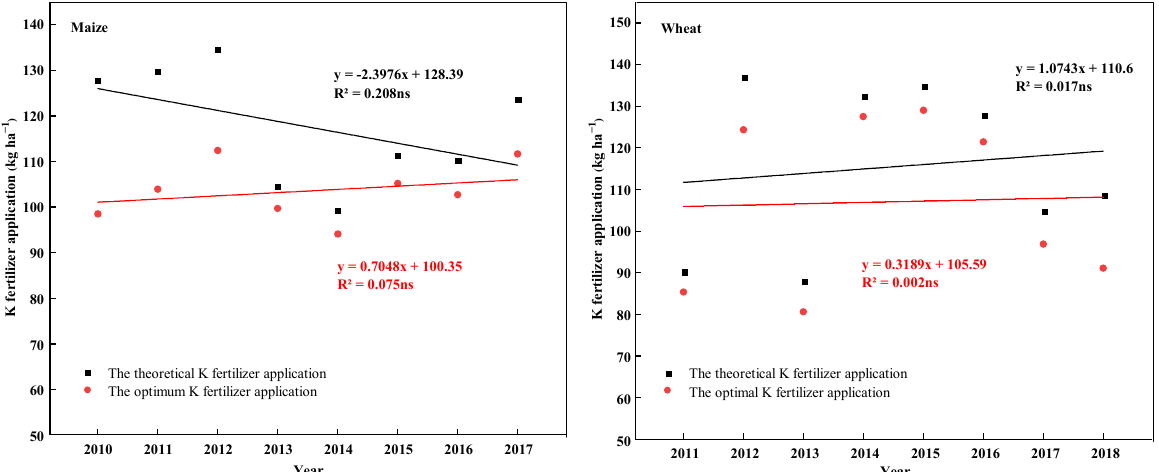
Figure 2. Relationship between the theoretical K fertilizer application and the optimal K fertilizer application of maize and wheat for eight years. The black solid line represents the fitting equation of the theoretical K fertilizer application. The red solid line represents the fitting equation of the optimal fertilizer application. ns, represents nonsignificant differences at the 0.05.